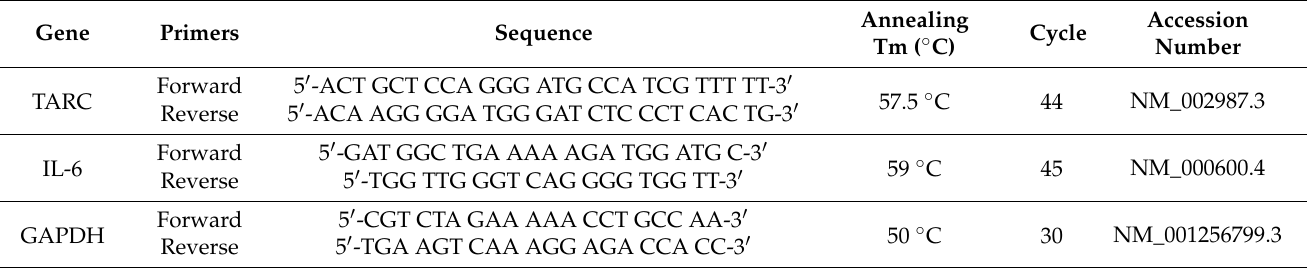
Table 1. Primer sequence and PCR